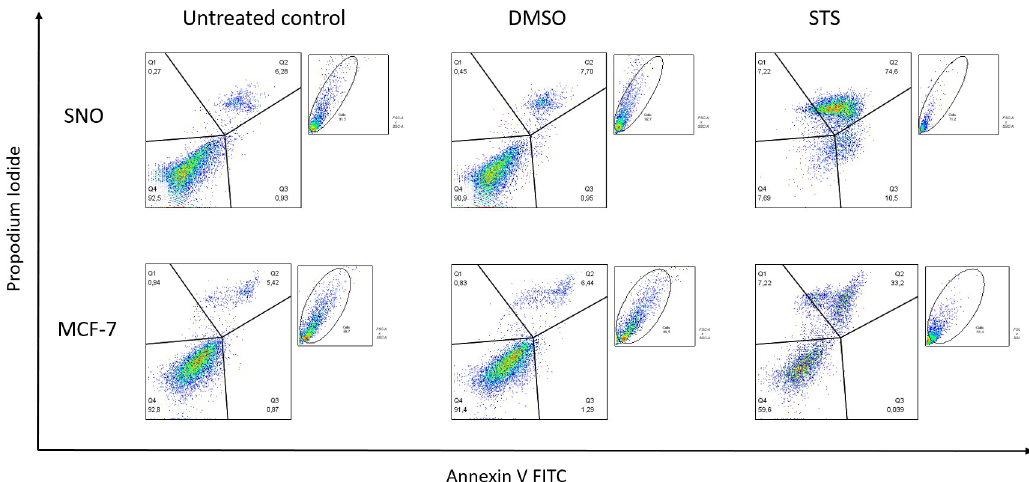
Fig 2. Induction of programmed cell death in an MCF-7 breast carcinoma and SNO oesophageal squamous cell carcinoma cell lines.